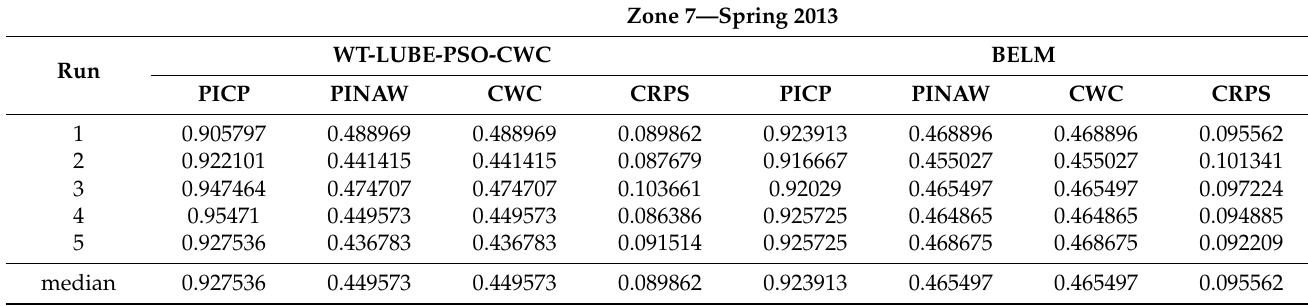
Table 10. Results of the evaluation of 5 training sessions of WT-LUBE-PSO-CWC and BELM models in zone 7 for spring 2013 at the 0.9 confidence